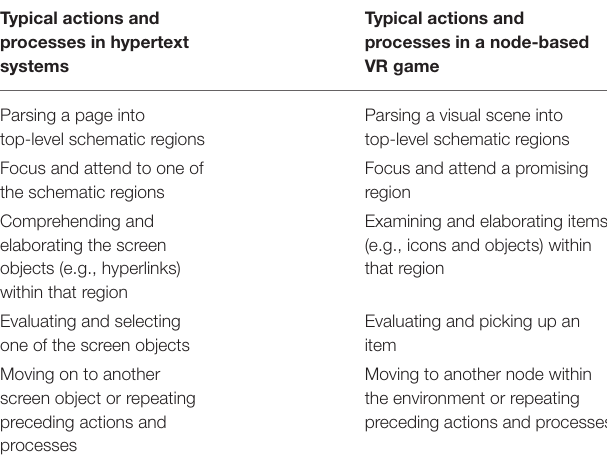
TABLE 1 | Similarities between navigation in hypertext and node-based VR